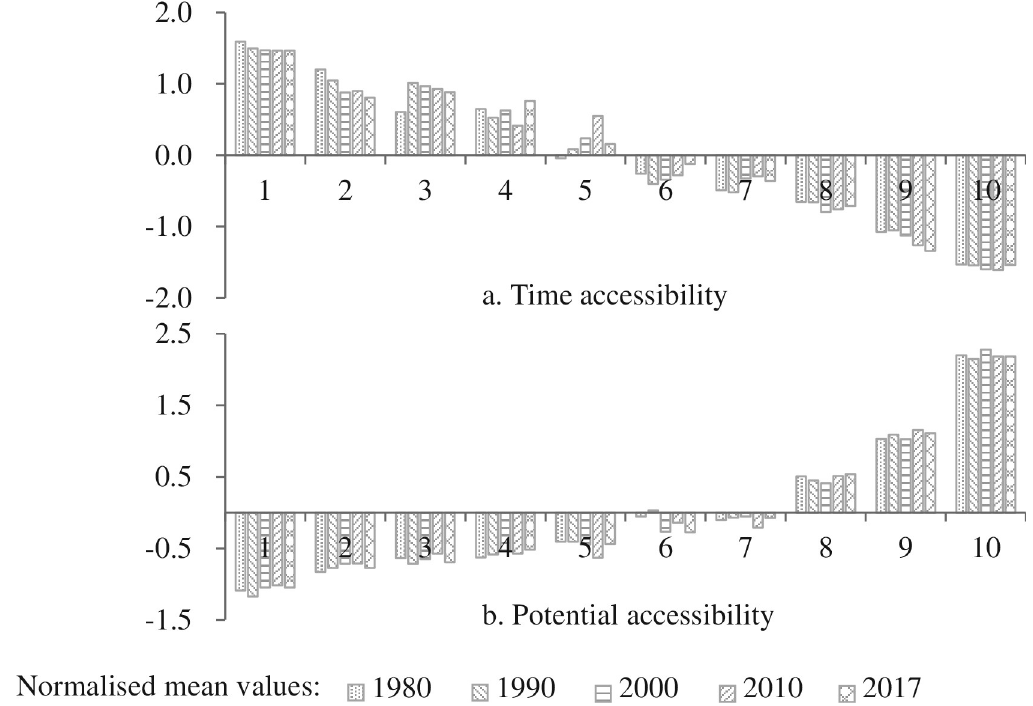
Fig 6. Transport accessibility represented by social demand index